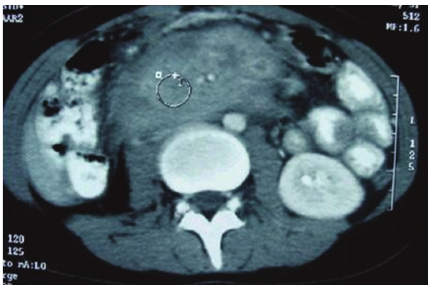
Figure 3: Abdominal computed tomography showing an 8 × 5 × 7 cm heterogeneous lesion with indefinite borders invading to the proximal part of small bowel in retroperitoneal